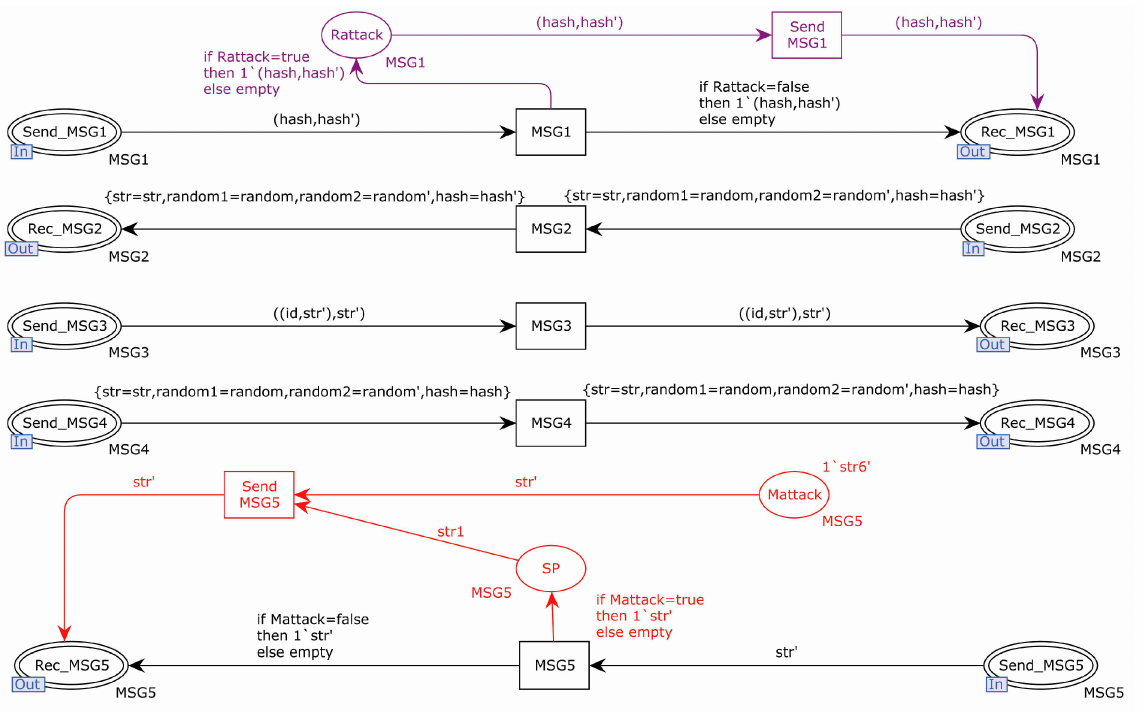
Figure 14. Tamper attack and replay attack at the network transport